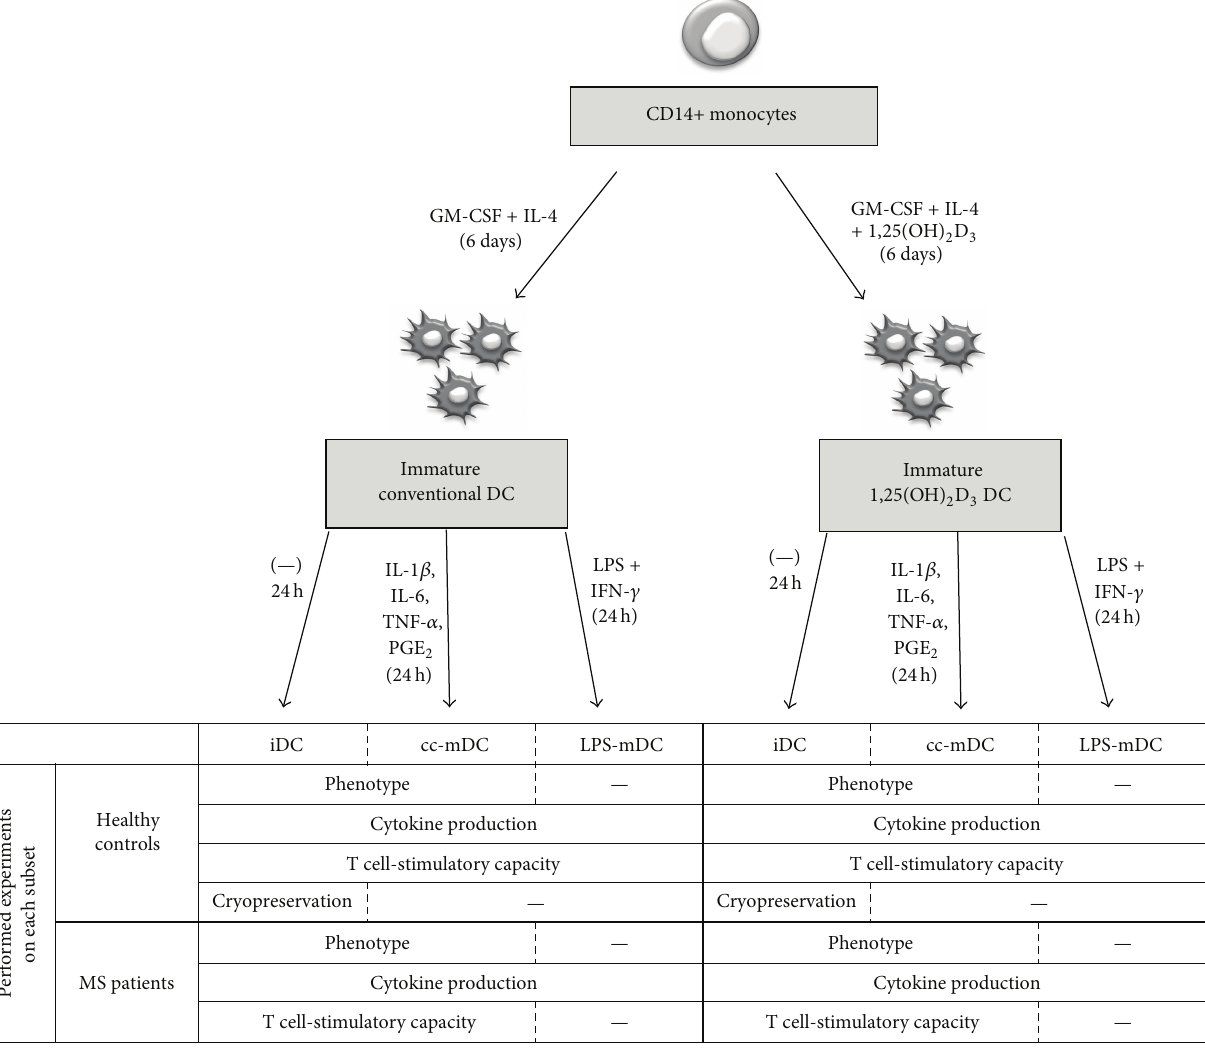
Figure 1: Experimental design. CD14+ monocytes were cultured for 6 days in the presence of IL-4 and GM-CSF or in the presence of IL- 4, GM-CSF, and 1,25(OH) 2 D 3 to obtain immature conventional DC (iDC) or 1,25(OH) 2 D 3 -treated iDC, respectively. On day 6, iDC were stimulated with a cocktail of proinflammatory cytokines (i.e., cc-matured DC (cc-mDC)) or with LPS and IFN- 𝛾 (i.e., LPS-matured DC (LPS-mDC)) or left untreated (i.e.,